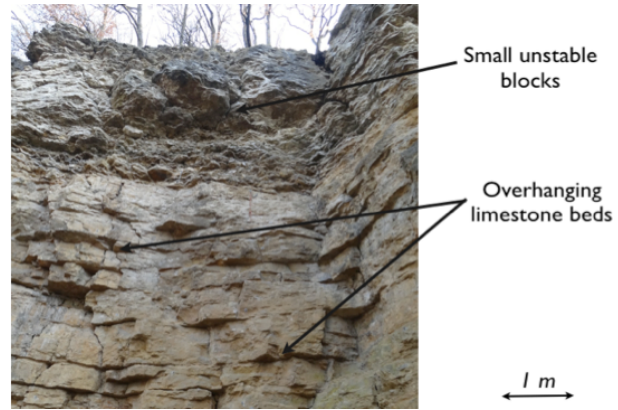
Figure 2. Sector 3 and its main characteristics (Delonca et al.,